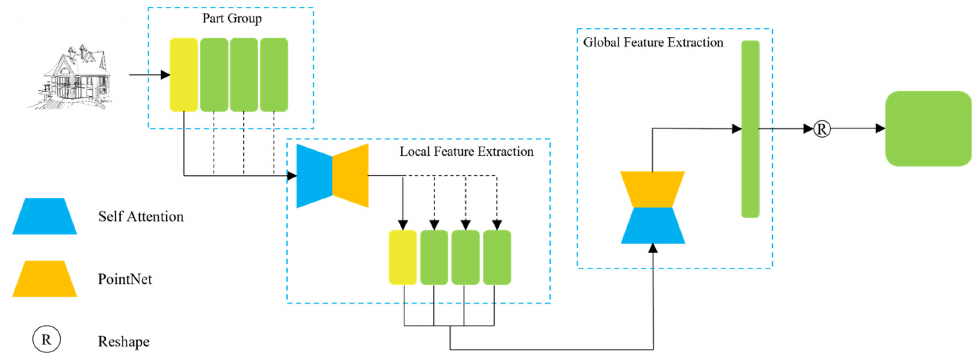
Figure 3. Flow chart of feature extraction of 3D target model.